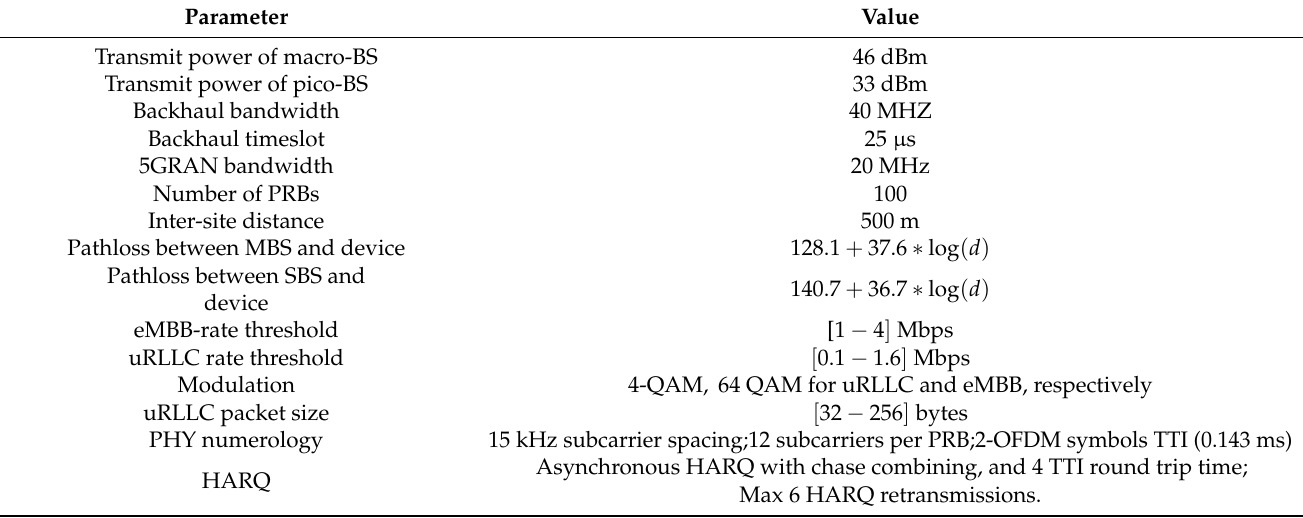
Table 3. Simulation